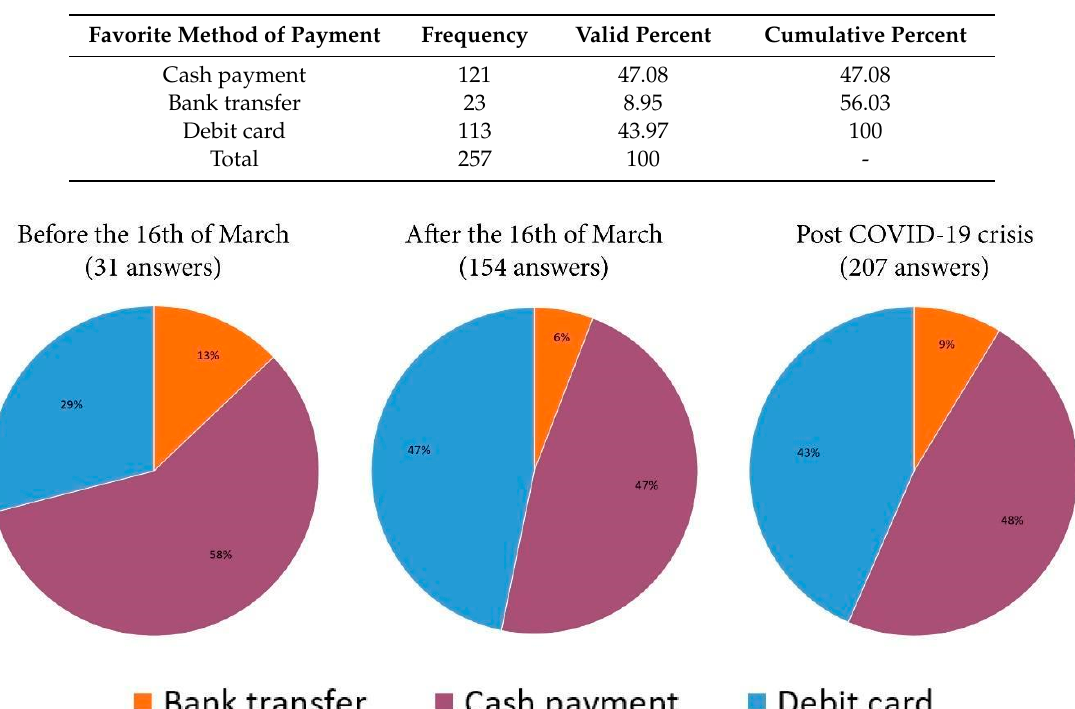
Table 7. Frequency of favorite payment methods (N = 257).